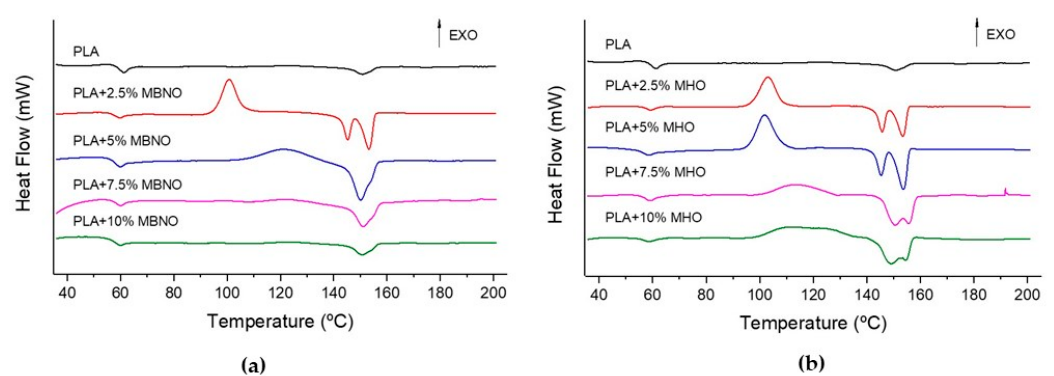
Figure 9. Dynamic DSC curve of PLA unplasticized and plasticized with different amounts of MBNO ( a ) and MHO content ( b ).